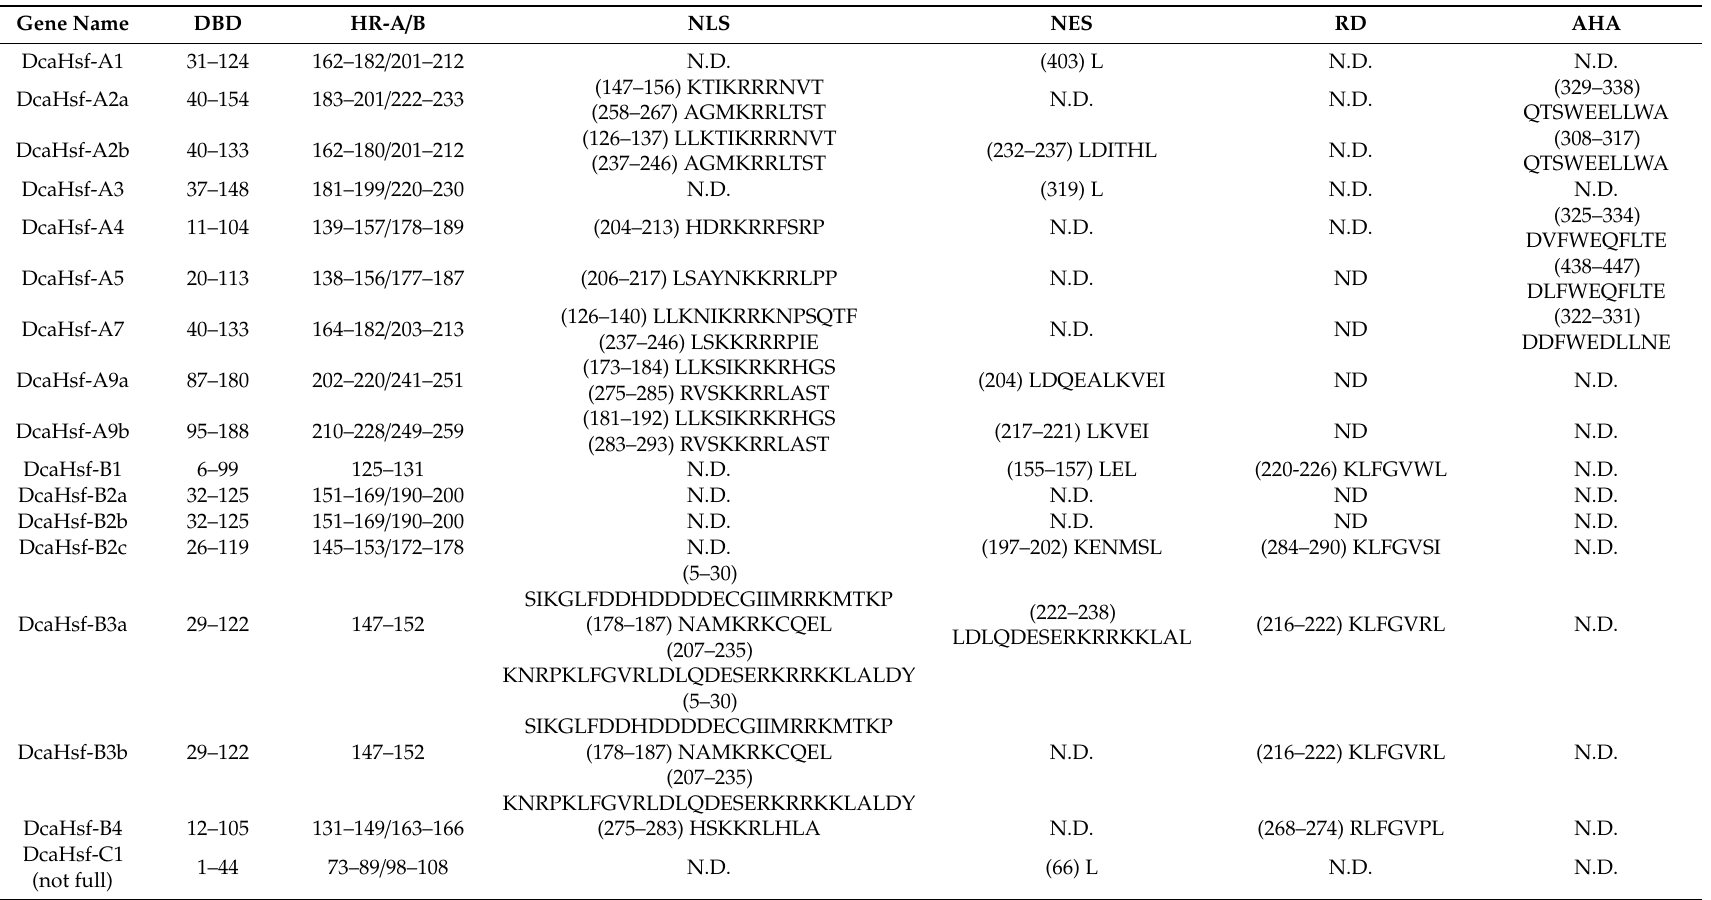
Table 3. Functional domains of